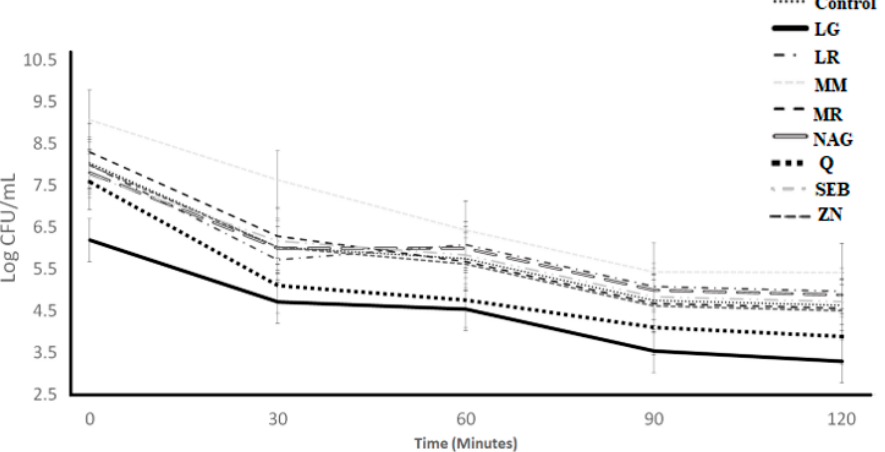
Figure 1. Log counts of Streptococcus thermophilus showing its acid tolerance as influenced by different ingredients over an incubation period of 120 min. C = control, LG = L-glutamine (7 g/L), Q = quercetin (700 mg/L), SEB = slippery elm bark (210 mg/L), MR = marshmallow root (1340 mg/L), NAG = N-acetyl-D-glucosamine (210 mg/L), LR = licorice root (210 mg/L), MM = maitake mushrooms (42 mg/L), and ZN = zinc orotate (70 mg/L). Error bars represent SE. Table 1. The p -value > F -value of ingredient, time or pH, and their interaction for bacterial viability, bile tolerance, acid tolerance, resistance to gastric juices, protease activity, and lysozyme resistance S. thermophilus and L. bulgaricus